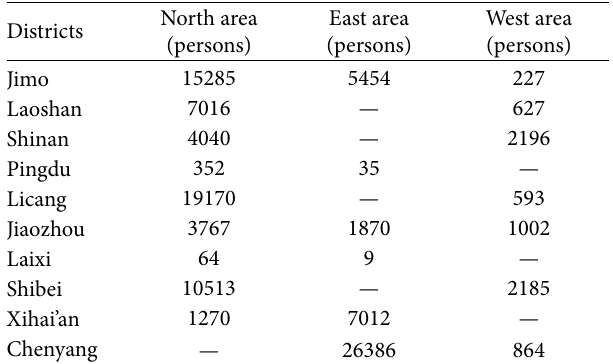
Figure 7: The internal-external linkage of east Table 4: The internal–external linkage strength between different areas and districts.